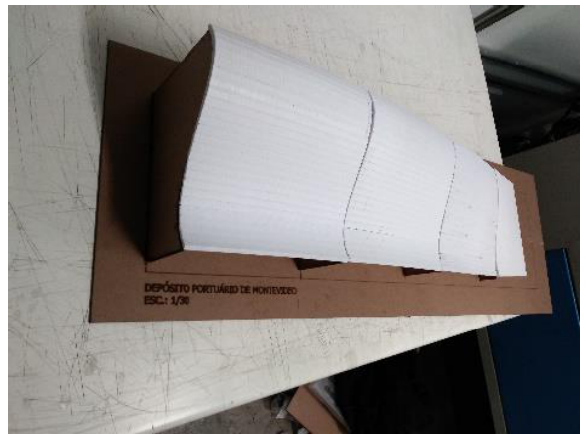
Figure 16: The complete roof surface of the Gaussian Vaults of the Seaport Deposit of Montevideo in a scale of 1:30.